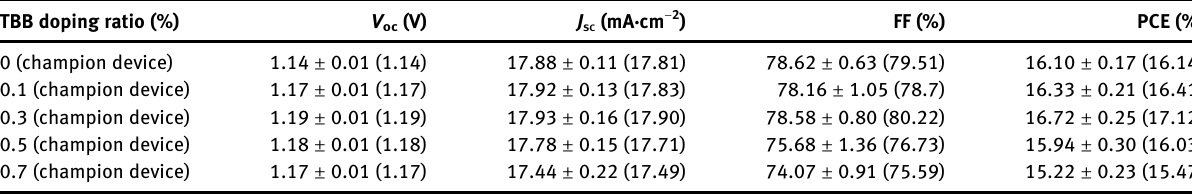
, short-circuit current density; PCE, power conversion ef fi ciency; PSC, perovskite solar cells; TBB,  ,  ,  -tris (bromomethyl) FF, fill factor; J SC benzene; V oc , open-circuit